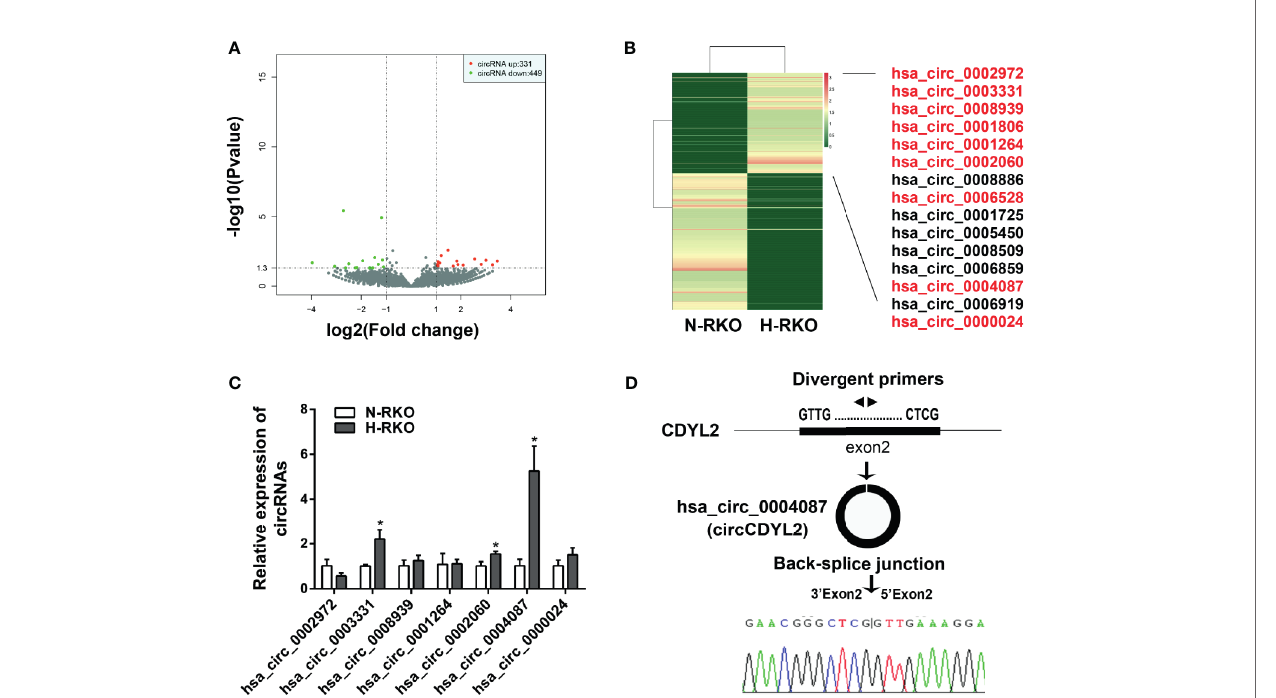
FIGURE 2 | CircCDYL2 was overexpressed in H-RKO. (A) Volcano plot of the differentially expressed circRNAs in H-RKO compared with N-RKO. Red: upregulated circRNAs. Green: downregulated circRNAs. (B) Heatmap of the differentially expressed circRNAs in H-RKO compared to N-RKO. Of the upregulated circRNAs, 15 were expressed in both H-RKO and N-RKO and 9 circRNAs with a length of less than 1000 bp marked with red color. (C) The relative expression levels of seven upregulated circRNAs in H-RKO were reassessed using RT-qPCR. (D) Schematic shows that circCDYL2 originated from exon 2 of CDYL2 gene by back-splicing. The divergent primers were designed to detect circCDYL2. Sanger sequencing con fi rmed that the back-splicing junction sequences of circCDYL2 were consistent with the head-to-tail sequences of CDYL2 exon 2. * p <